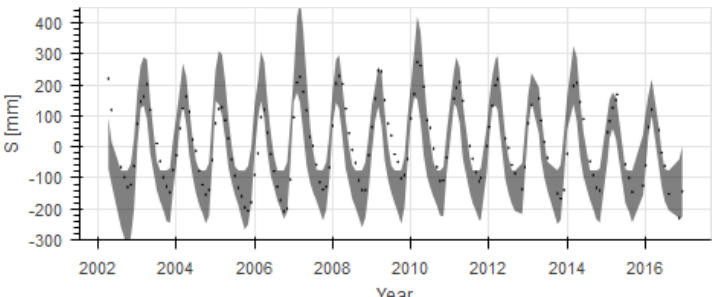
Figure 9. Range of random model realizations with respect to the total water storage (grey) including the observation according to GRACE (black).